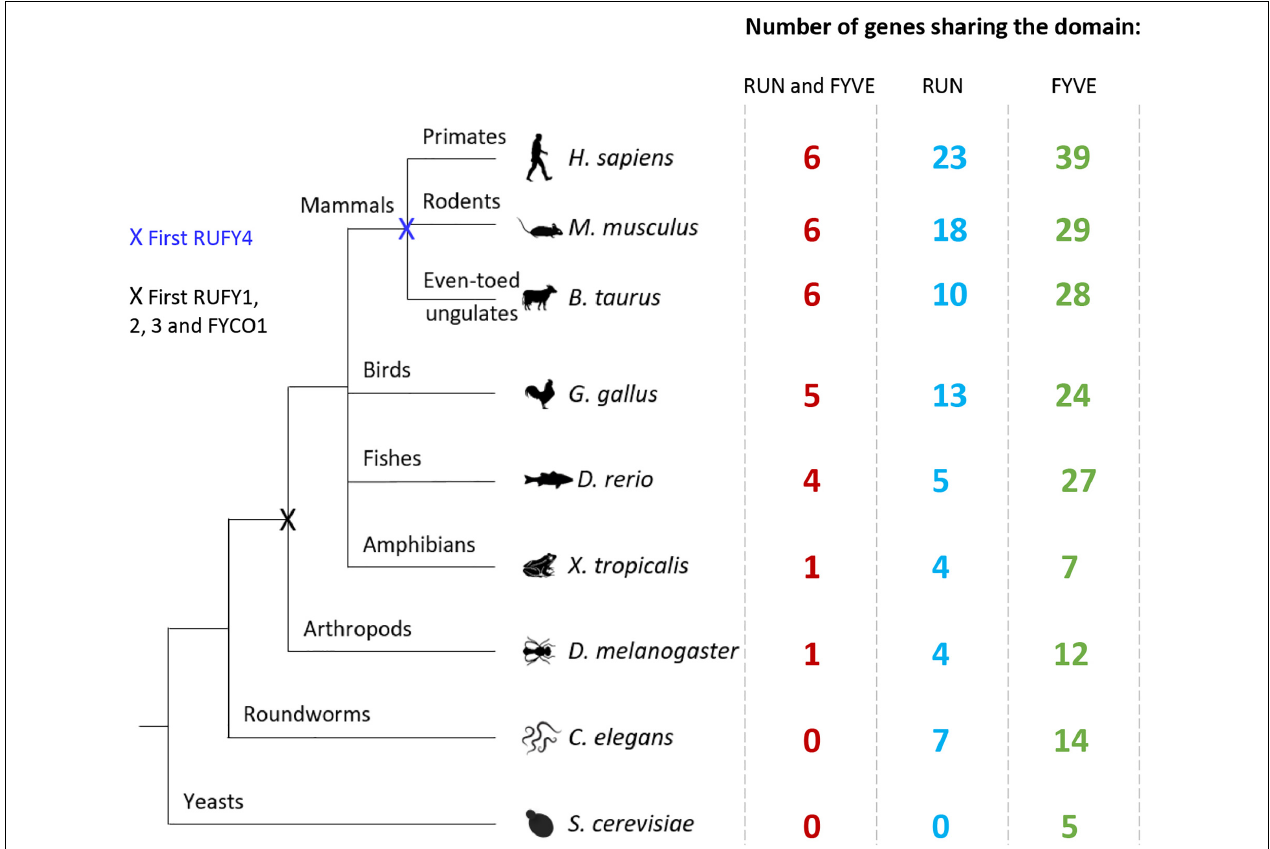
FIGURE 2 | Evolution of RUN and FYVE domain or rufy genes among living organisms. Diagram illustrating the evolution of the rufy genes. Species representative of various taxonomic groups are listed, data were extracted from the Differential Expression Atlas Genes database (EMBL-EBI). Next to each species studied, the number corresponds to the number of genes having in its sequence a FYVE (green), RUN (blue) or both (red) domain. The “X” corresponds to the appearance of a common rufy ancestor gene.